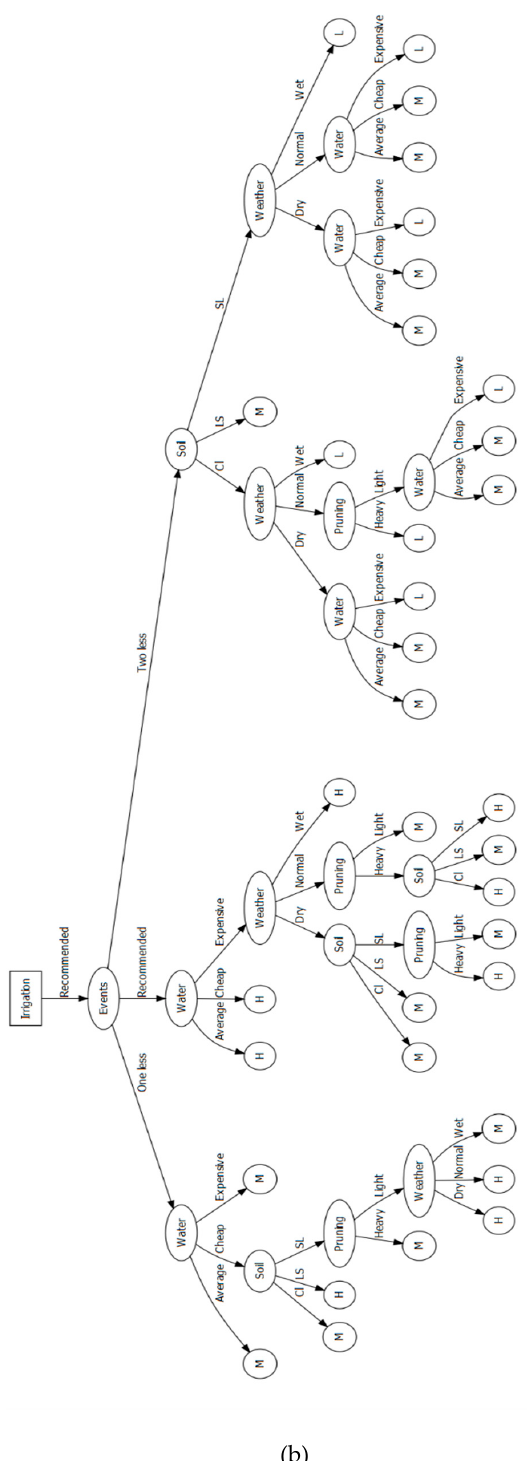
Figure 5. Decision tree using the ID3 algorithm for (a) 75% of the recommended irrigation and (b) Figure 4. Decision tree using the ID3 algorithm for ( a ) 75% of the recommended irrigation and ( b ) 100% 100% of the recommended irrigation. of the recommended